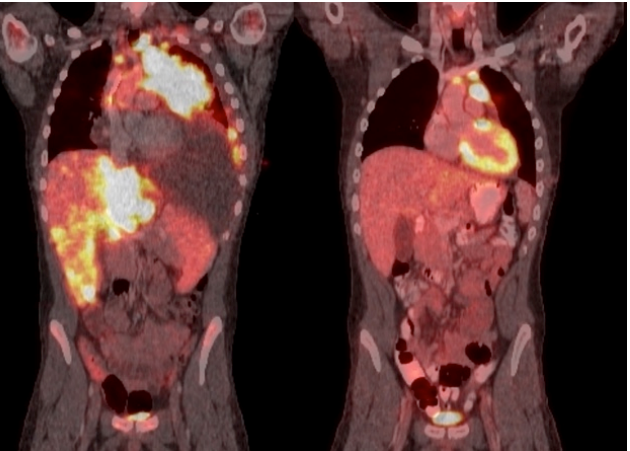
Figure 2. PETCT response of a patient with lymphoblastic lymphoma after one cycle of venetoclax combination therapy. PETCT response of patient 2 (see Table 2), with lymphoblastic lymphoma after one cycle of venetoclax combination therapy.